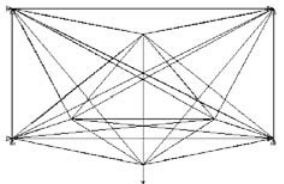
Fig. 15. All possible connections in 8-node truss system